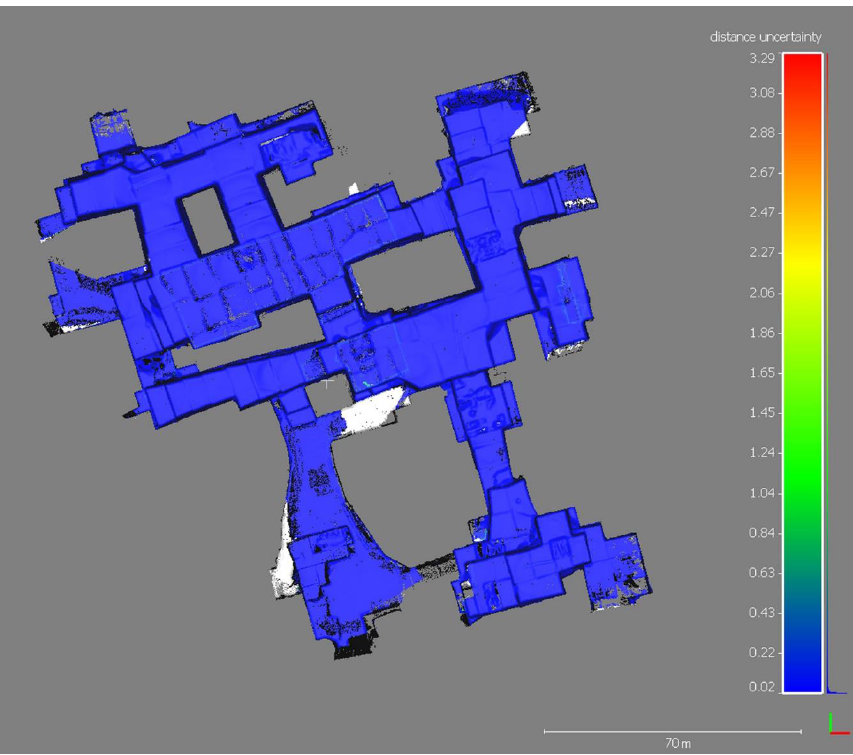
Figure 8. Map of distance uncertainty between corresponding points (the measurement unit of the color bar is meter).